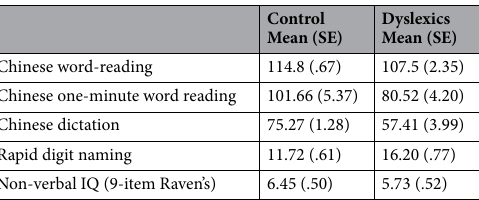
Table 1. Summary of the scores of Chinese literacy performance and non-verbal IQ (9-item Raven’s) in college students with and without